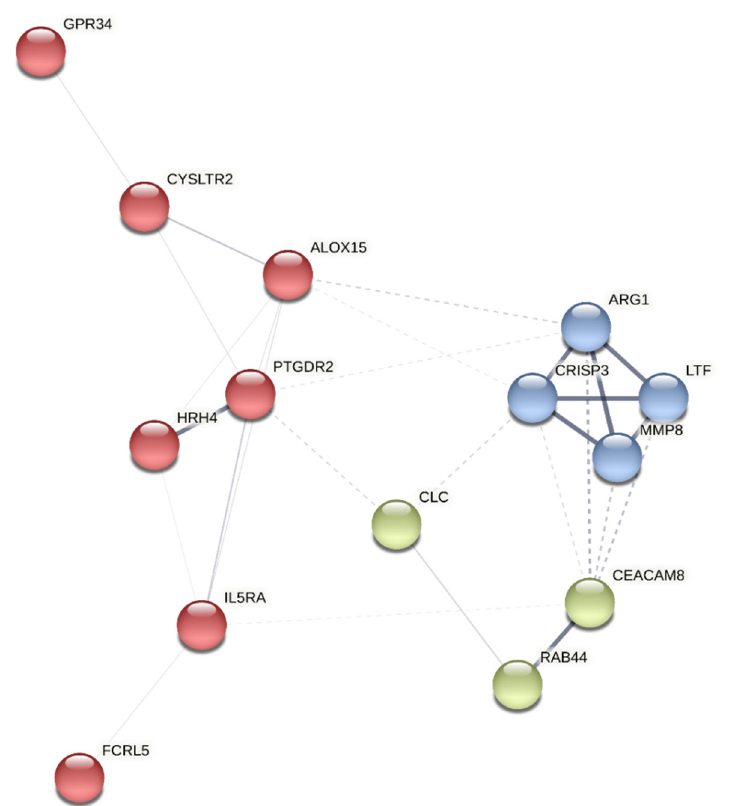
Figure 1. Cluster analysis of the most differentially expressed genes using the STRING platform. The identified clusters are colored in red (A), blue (B), and green (C). The solid and the dotted lines indicate connections within the same and different clusters, respectively. Table 3. Gene ontology biological process enrichment analysis for most differentially expressed genes. PTGDR2 gene is highlighted in bold.